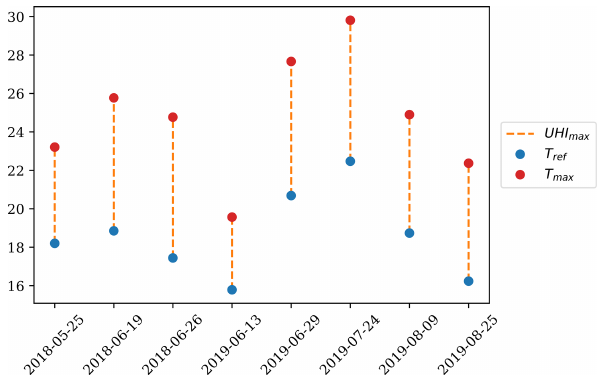
Figure A1. Reference temperatures T ref (i.e., minimum T air at 21:00CET among the monitoring stations) and magnitude of the UHI UHI max (i.e., difference between T ref and the maximum T air at 21:00CET among the monitoring stations) for the eight dates considered in this